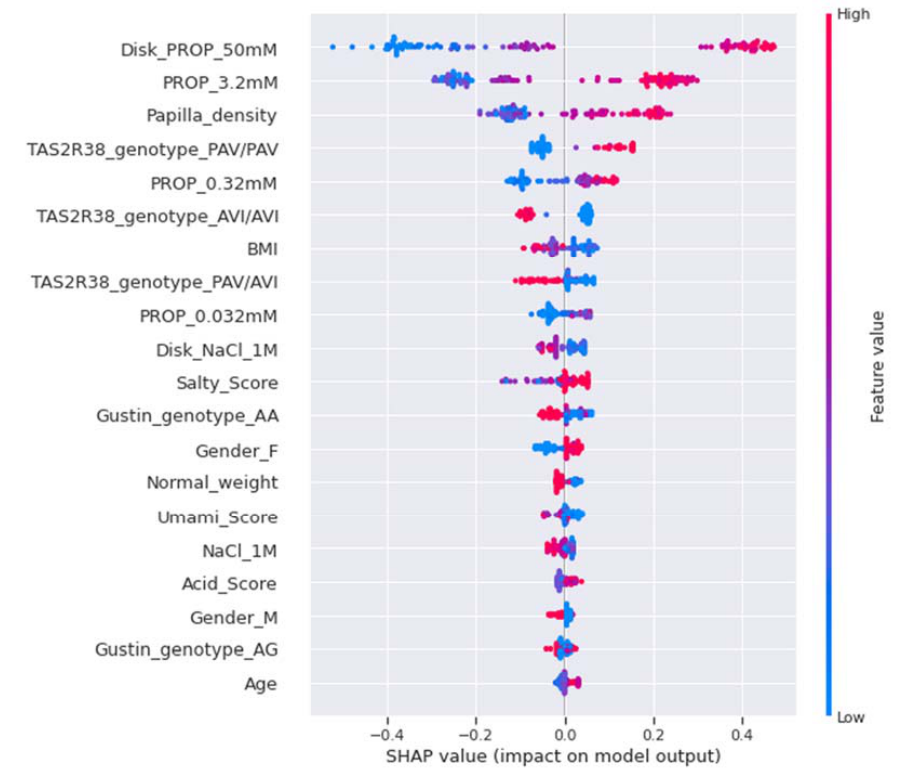
Figure 6. SHAP summary plot of the ST category. The left ‐ hand side of the Y ‐ axis represents the descending order of importance of the ST category features; the X ‐ axis represents the impact of the SHAP value on the output model. The color represents the feature value: high values have a pink color, while low values have a blue one.